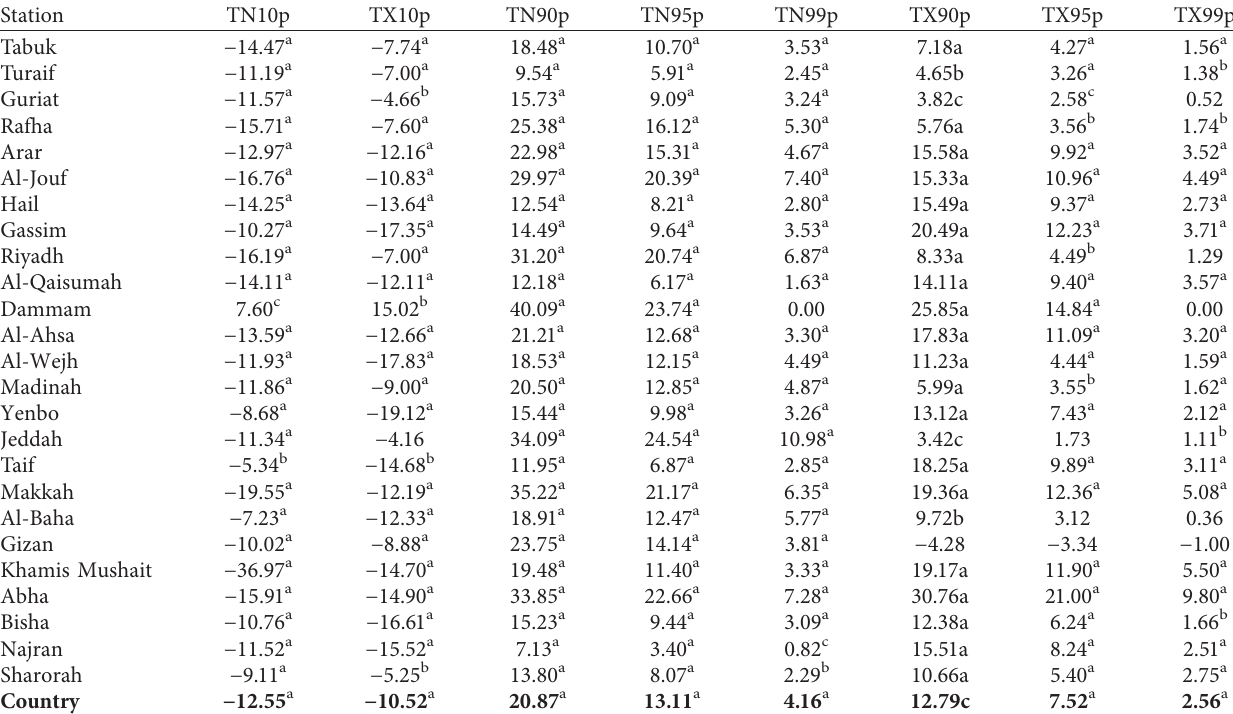
Table 5: Relative value indices linear trends (days per decade) at different station locations in Saudi Arabia for the period 1978–2019. Station